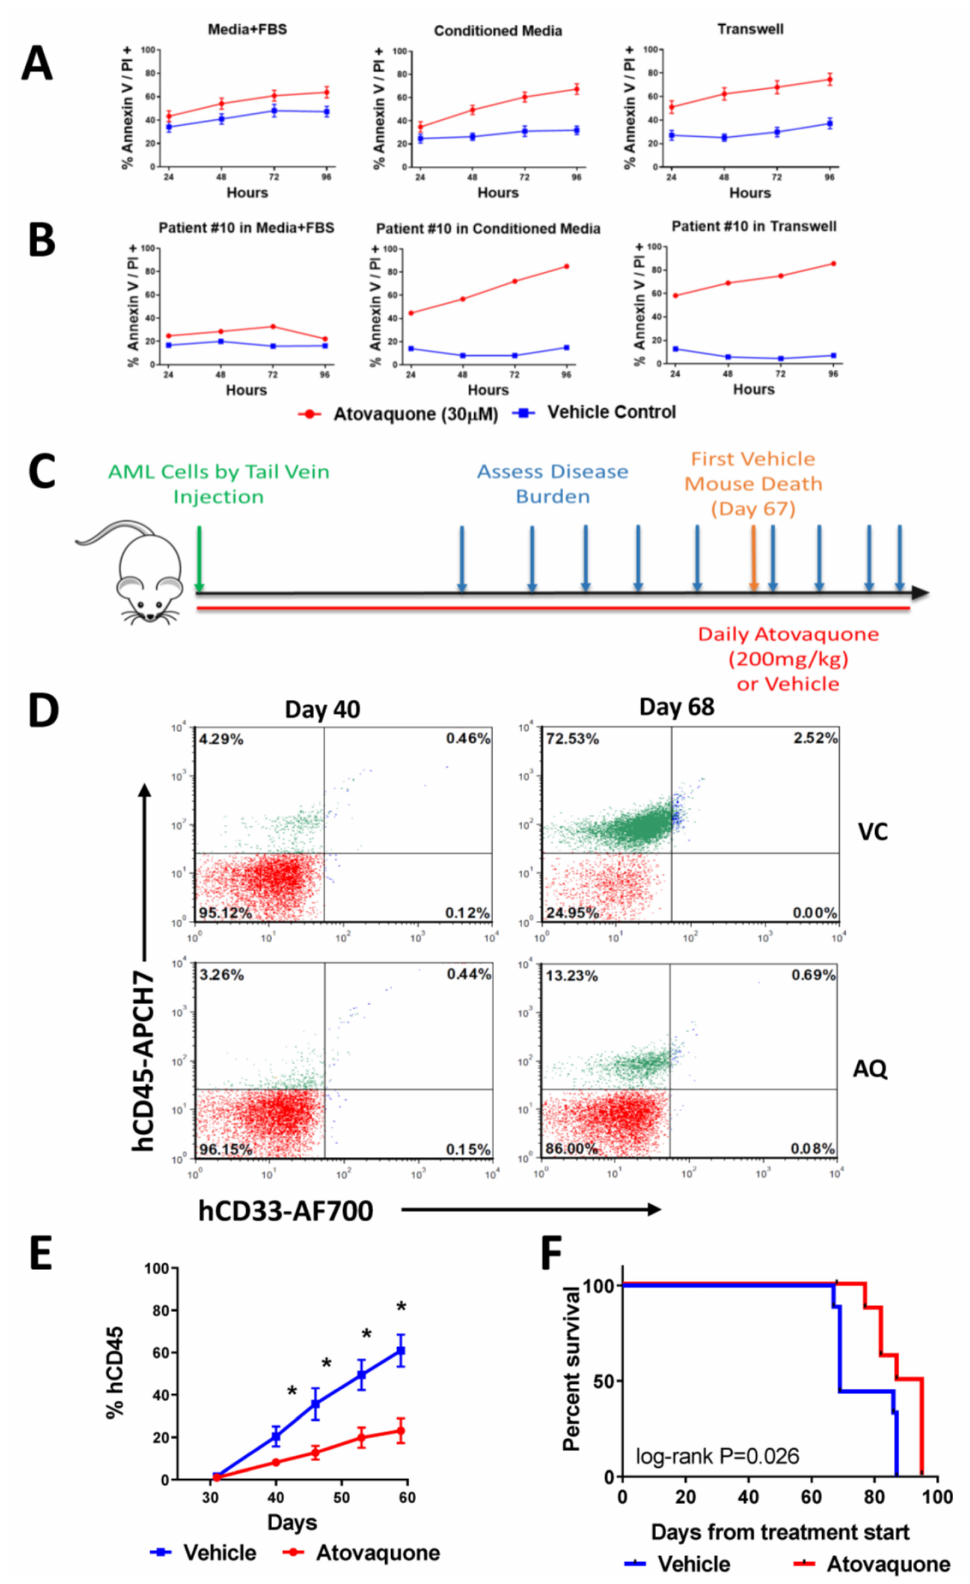
Figure 4. AQ induces apoptosis for ex vivo patient samples and Single-agent treatment with AQ decreases disease burden and prolongs survival in a patient-derived xenograft model. ( A ) Com- posite data on spontaneous vs. atovaquone induced apoptosis of primary patient samples incubated in different conditions: media with 20% fetal bovine serum (FBS), HS-5 conditioned media, or